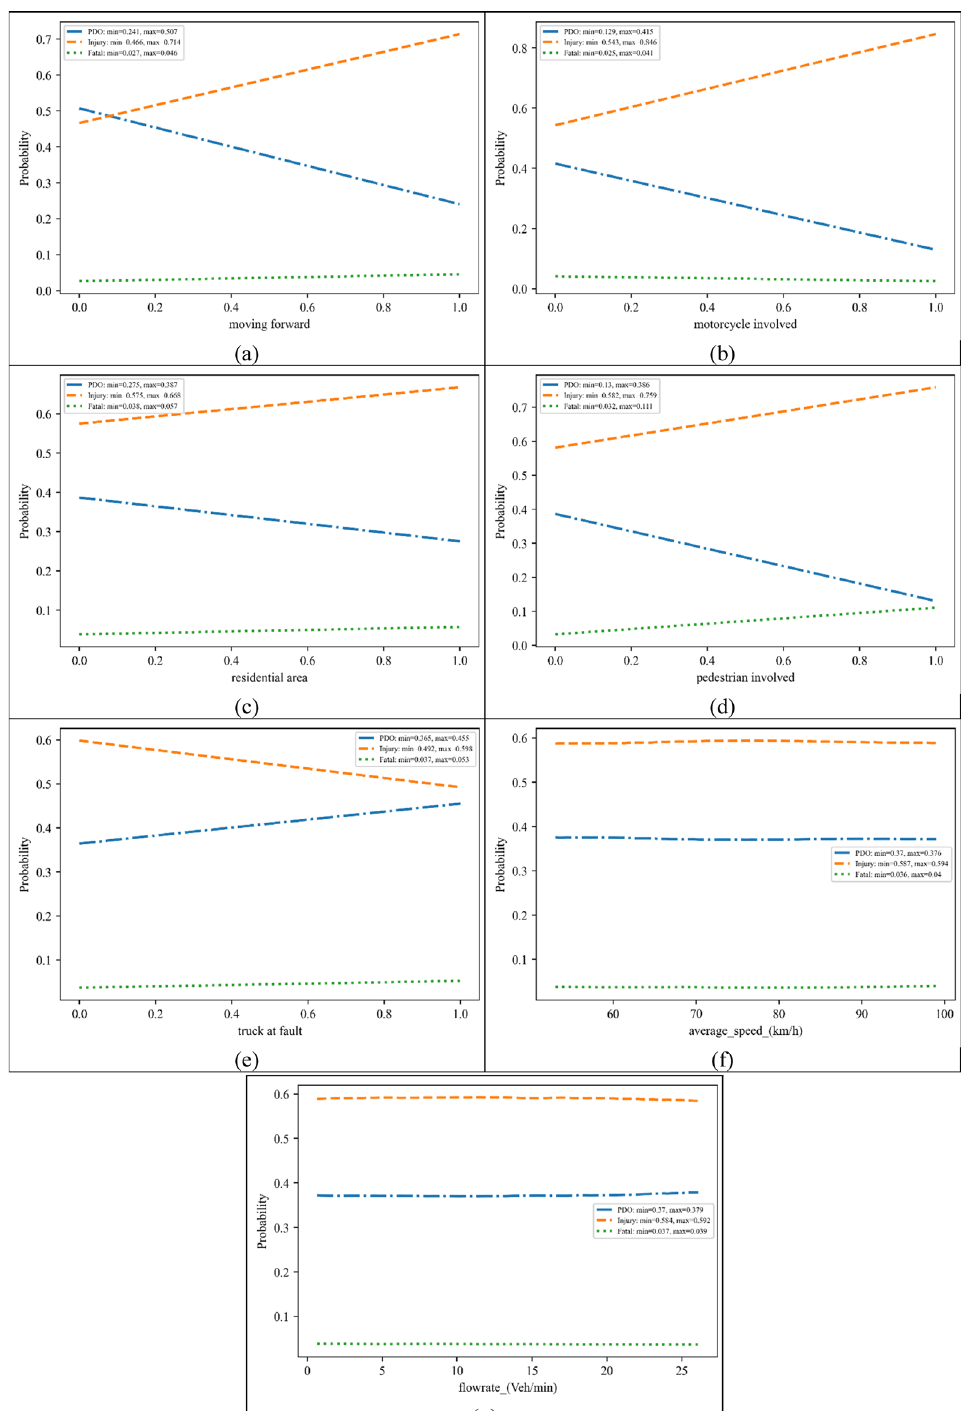
Figure 4. PDPs for the most influencing variables on crash severity [plotted by Python Matplotlib v. 3.3.4 https:// matpl otlib.